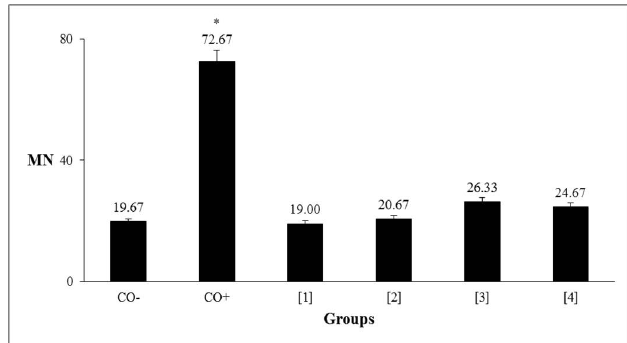
FIGURE 3 - The average number of micronuclei (MN) for the negative (CO-) and positive (doxorubicin) control groups and for groups treated with concentrations of 0.2 [1], 1.0 [2], 5.0 [3] and 10 [4] μg/mL of flunitrazepam in vitro . * Statistically significant result compared with the negative control (p <